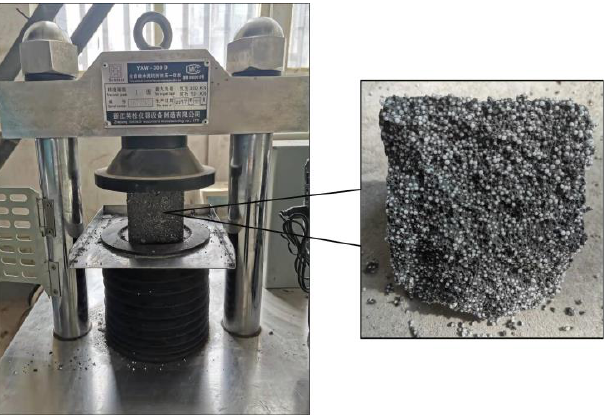
Figure 8. Failure samples after an unconfined compressive strength test.